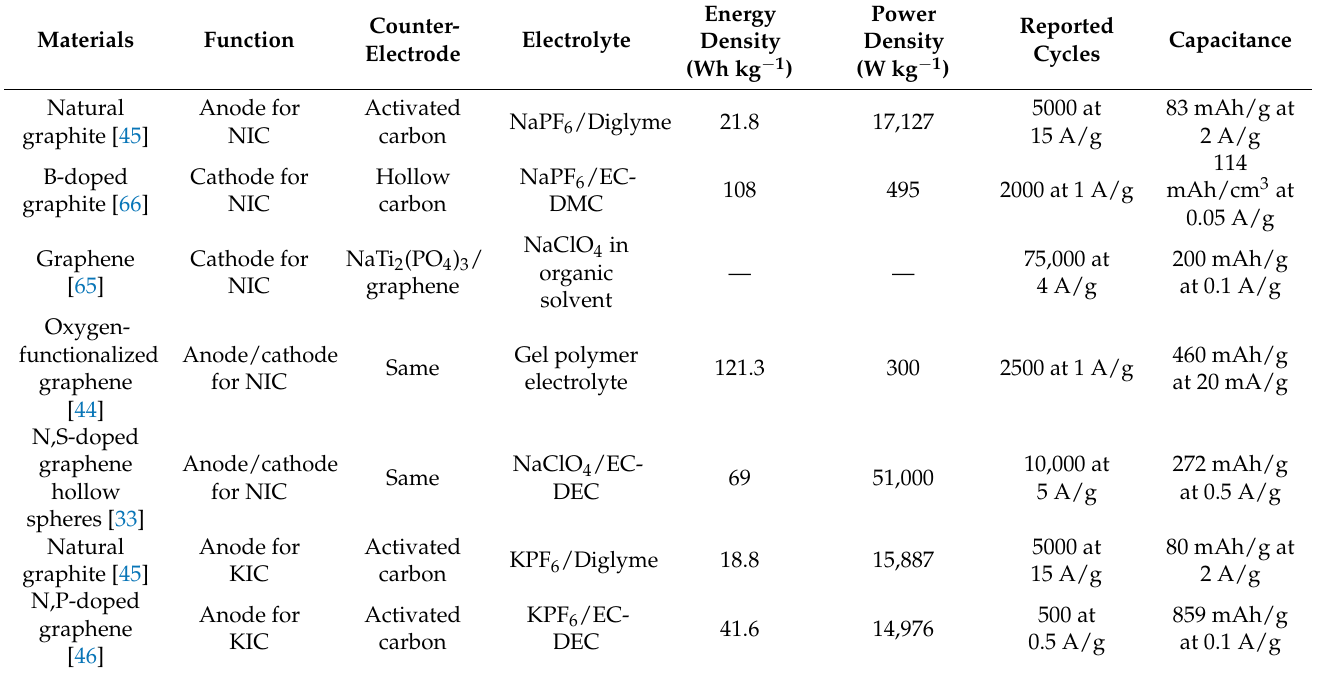
Table 1. Graphite/graphene for post-Li hybrid